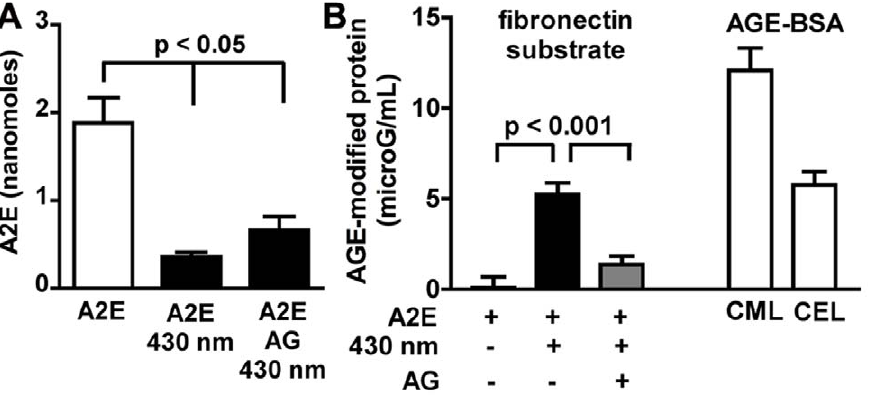
Figure 4. AGE-modification of a fibronectin substrate accompanies photooxidation/photodegradation of intracellular A2E. ( A ) A2E content of ARPE19 is diminished by irradiation (430 nm) in the presence/absence of aminoguanidine (AG). UPLC quantitation; Mean 6 SEM of 3 experiments. ( B ) AGE-modification of fibronectin substrate underlying irradiated A2E-containing ARPE19 cells. Prior accumulation of aminoguanidine within the cells reduced AGE-formation. ELISA quantitation as AGE-BSA equivalent units. The anti-AGE antibody recognized both carboxymethyllysine (CML)-BSA and carboxyethyllysine (CEL)-BSA. + presence of condition. Mean 6 SEM of 7 experiments.